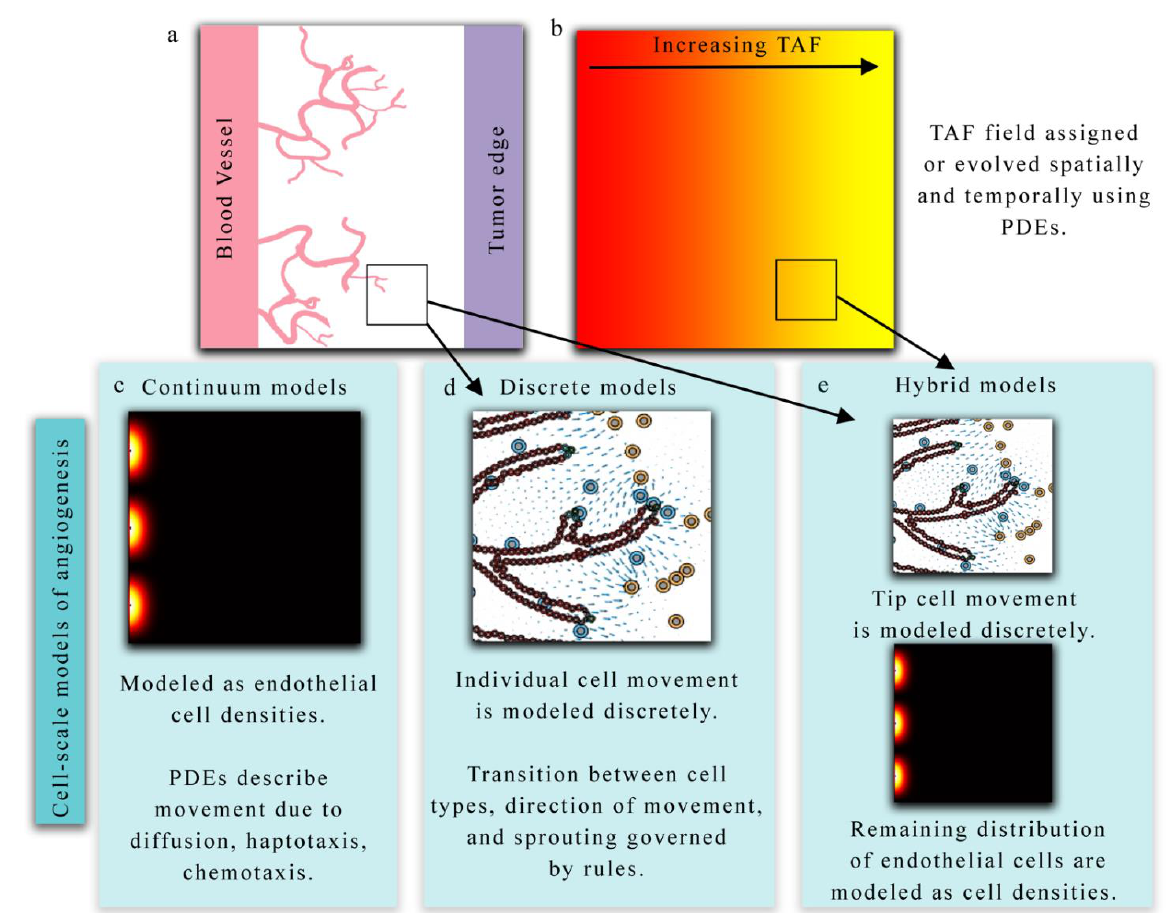
Figure 2. Overview of cell-scale models of angiogenesis. (Panels a and b ) present a hypothetical biological scenario in which new vasculature is recruited via angiogenesis in response to tumor angiogenic factors (TAF) released by tumor cells. Continuum models (panel c ) describe this phenomenon in terms of endothelial cell densities and the concentration of TAF. Partial differential equations (PDEs) provide a continuous representation of endothelial densities and often describe the spatial and temporal evolution via diffusion, haptotaxis, and chemotaxis terms. Alternatively, discrete models (panel d ) can be used to explicitly describe the movement and behavior of each individual endothelial cell. Hybrid models (panel e ) generally combine both discrete and continuum approaches to model TEC movement and endothelial cell densities, respectively, in response to